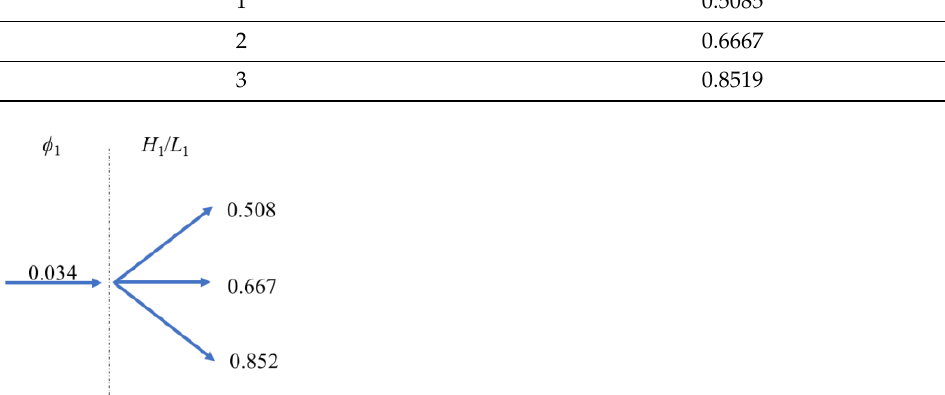
Figure 5. Illustration of the Constructal Design applied to the OTD-WEC with one ramp.